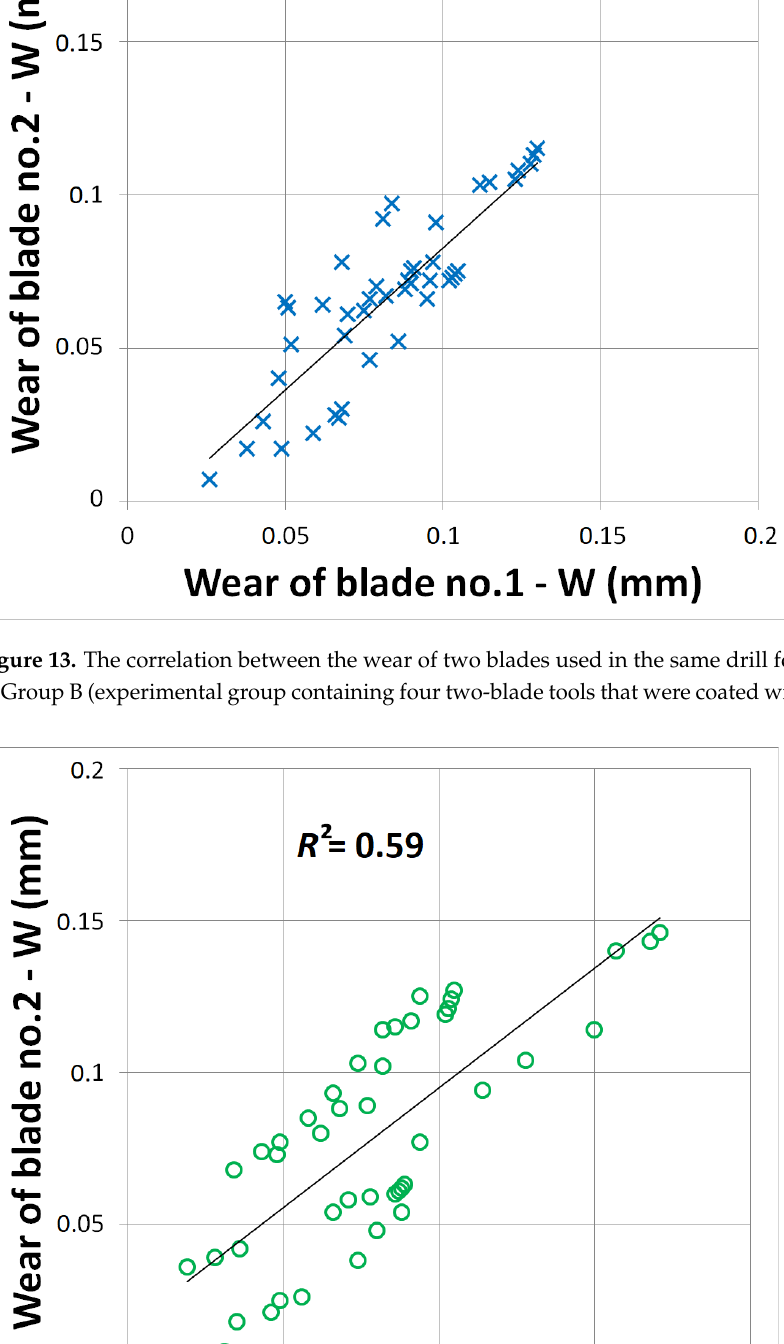
Figure 12. The correlation between the wear of two blades used in the same drill for tools belonging to Group A (control group containing four two-blade tools that were unmodified).